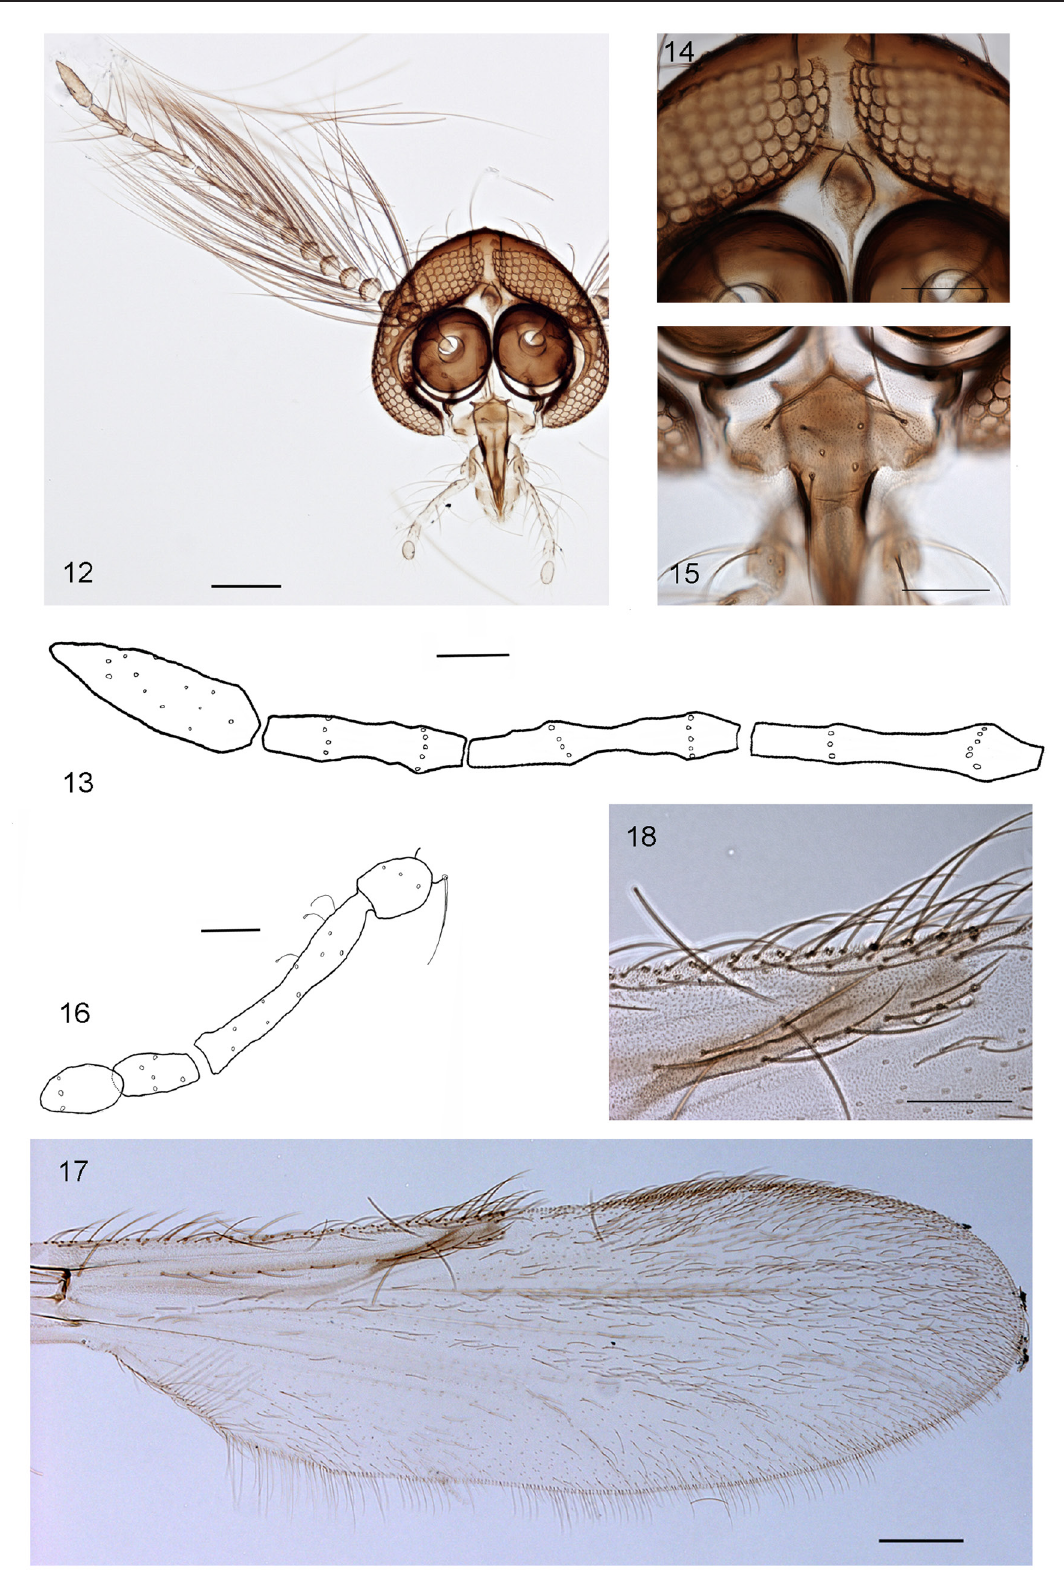
Figs 12–18. Dasyhelea gothlandica sp. nov., holotype, ♂. 12 . Head. 13 . Distal flagellomeres. 14 . Frontal sclerite. 15 . Clypeus. 16 . Palp. 17 . Wing. 18 . First and second radial cell of wing. Scale bars: 12, 17 = 100 µm; 14, 18 = 50 µm; 13, 15–16 = 25